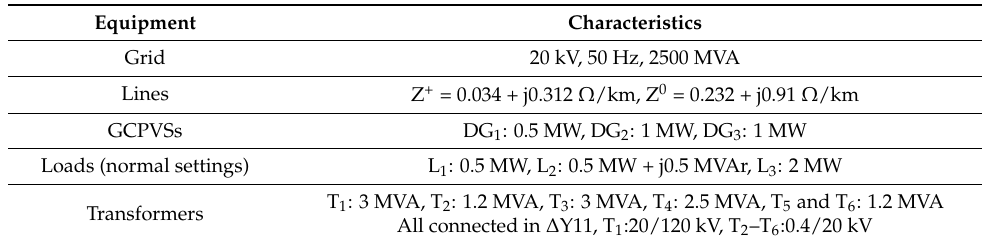
Figure 5. Case study system under evaluation. Table 1. Details of the case study system.